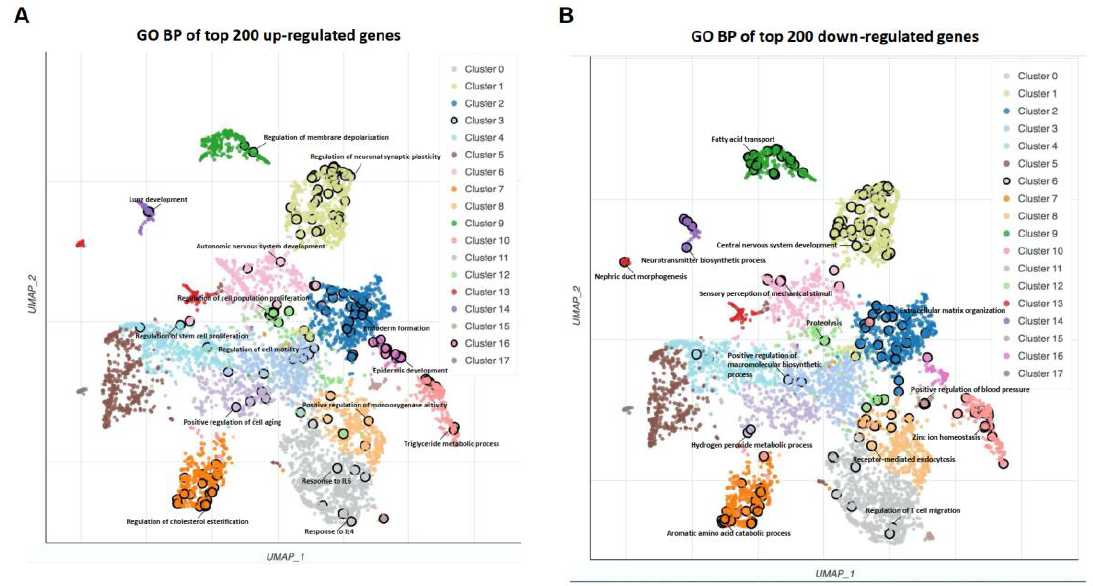
Figure 2. Gene ontology analysis. ( A ) GO biological processes of the top 200 upregulated DEGs. ( B ) GO biological processes of the top 200 downregulated DEGs.